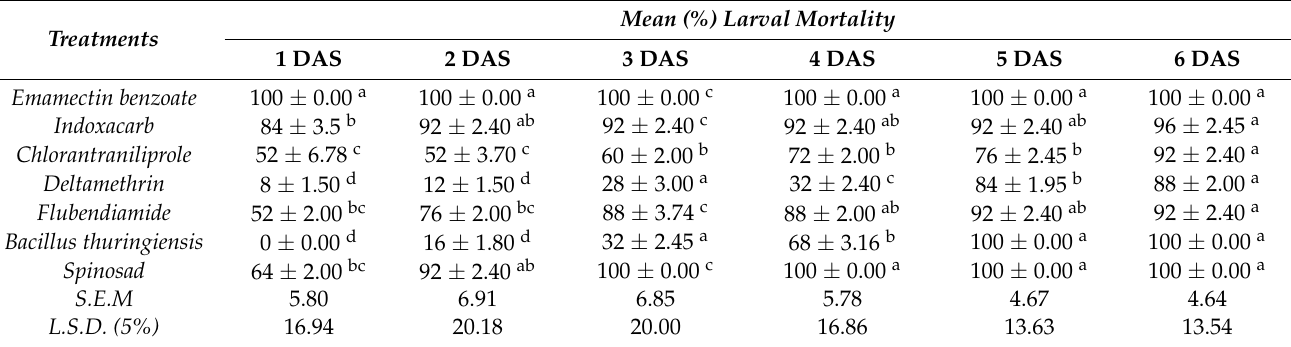
Table 4. Systemic toxicity over time after exposure to different insecticides against third instar larvae of H. armigera using the systemic